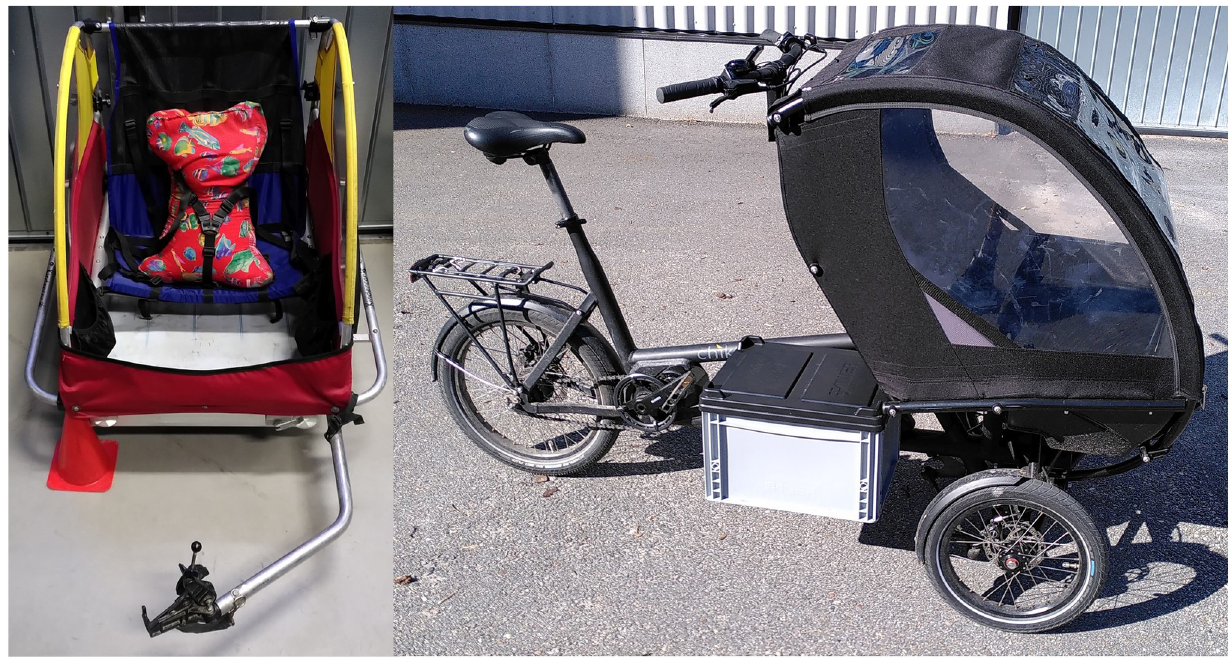
Fig 1. Test vehicles for child transport used in this study: Cycle carrier Kindercar with dummy (left) and Cargotrike Chike.